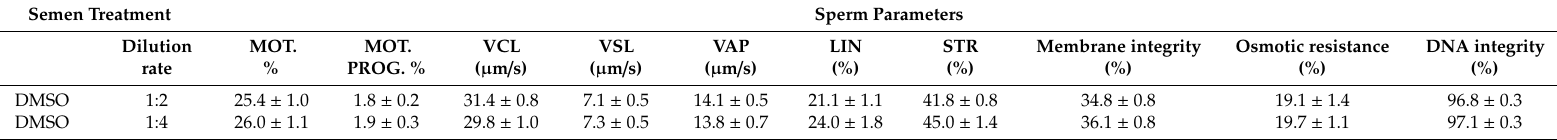
Table 3. Sperm quality variables (mean ± S.E.M.) recorded in turkey semen frozen in the presence of DMSO according to two dilution rates (N = 8). Semen Treatment